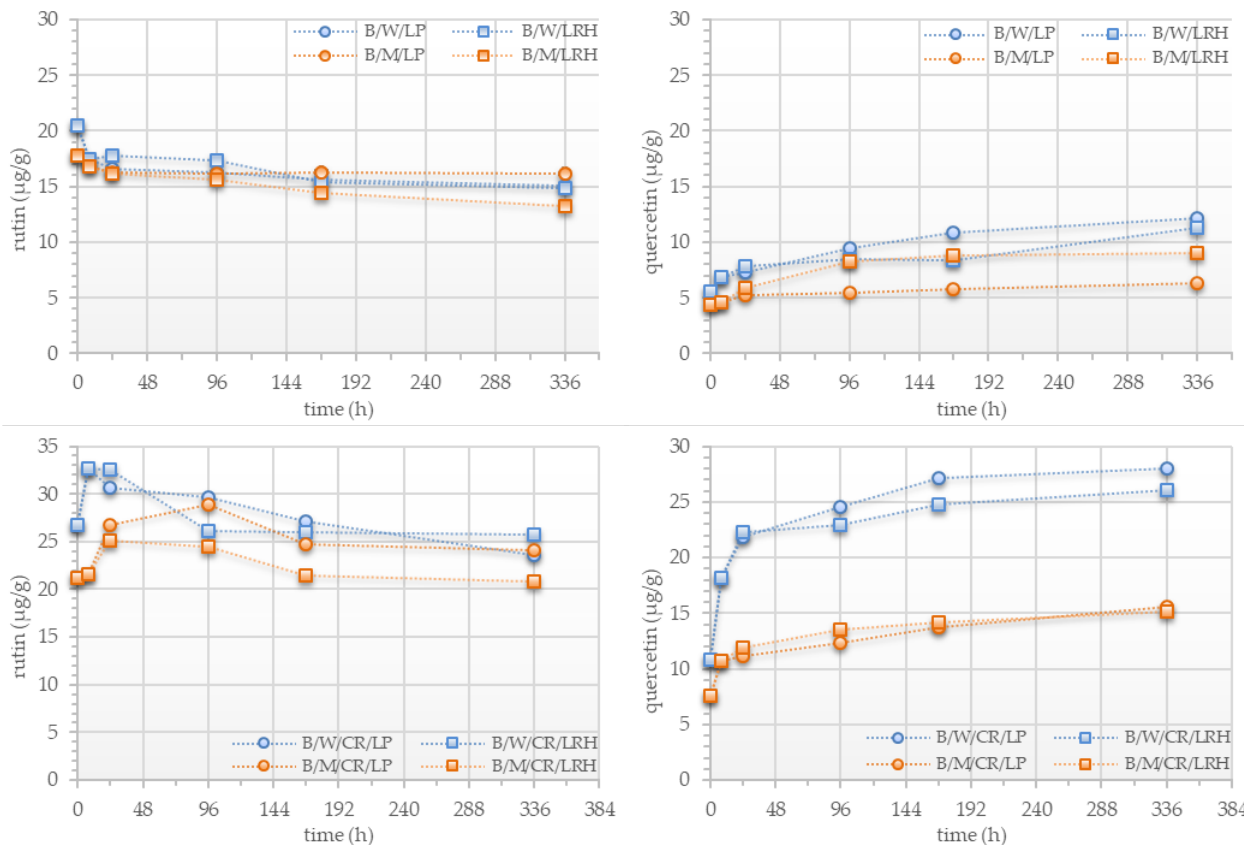
Figure 1. Rutin and quercetin content of buckwheat mashes obtained by HPLC analysis (µg/g). B/W/LP: buckwheat/water/ L. plantarum HM1; B/W/LRH: buckwheat/water/ L. rhamnosus GG; B/M/LP: buckwheat/milk/ L. plantarum HM1; B/M/LRH: buckwheat/milk/ L. rhamnosus GG; B/W/CR/LP: buckwheat/water/cranberries/ L. plantarum HM1; B/W/CR/LRH: buckwheat/water/cranberries/ L. rhamnosus GG; B/M/CR/LP: buckwheat/milk/cranberries/ L. plantarum HM1; B/M/CR/LRH: buckwheat/milk/cranberries/ L. rhamnosus GG.